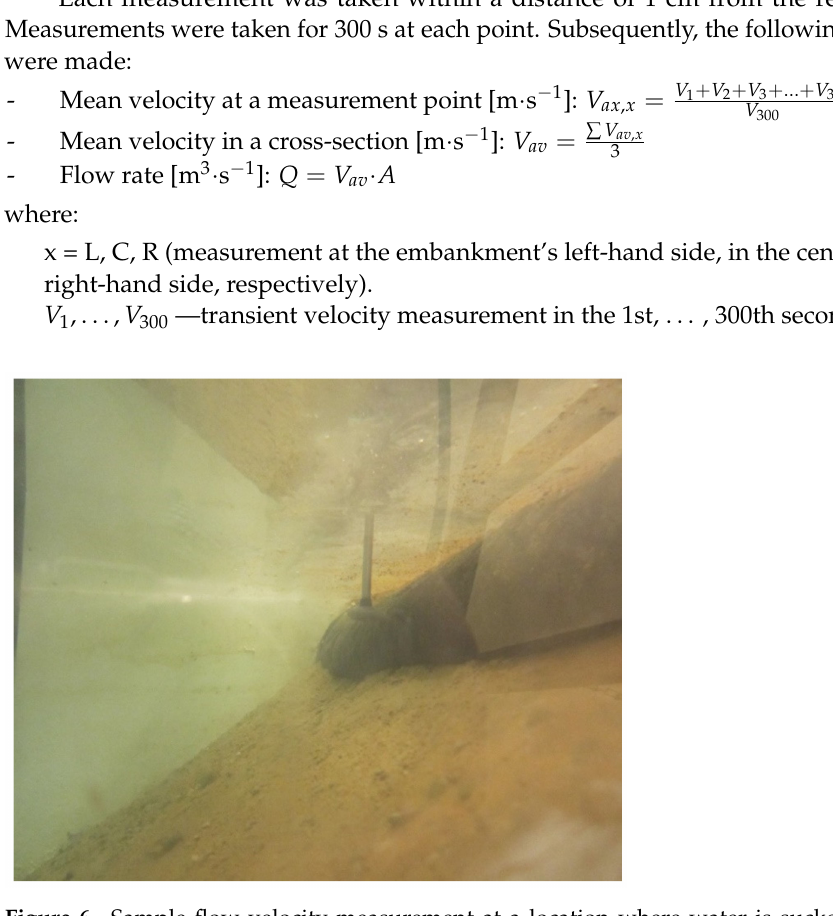
(denoted on the charts as L—embankment left-hand side, C—centre, and R—right-hand side, respectively).